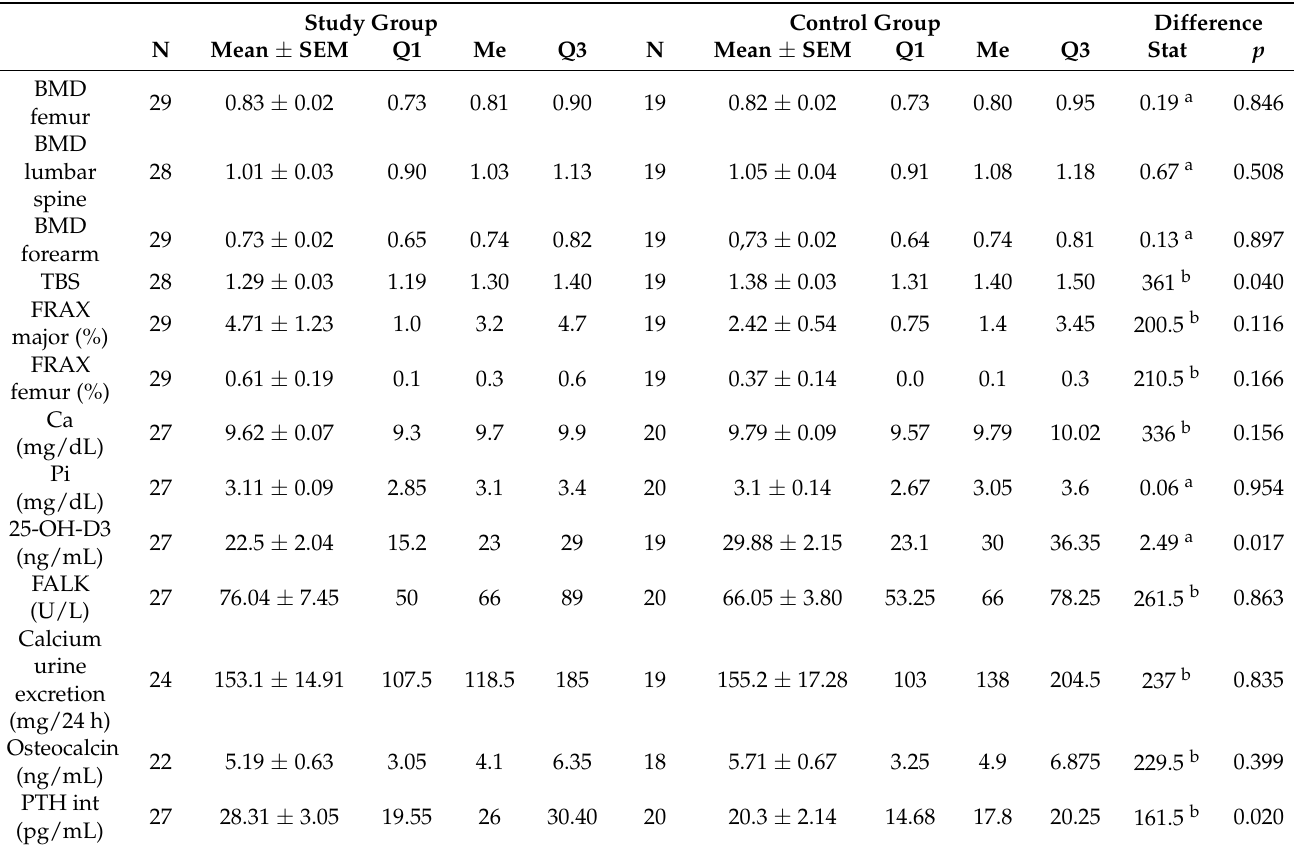
Table 2. Densitometric and laboratory parameters of the calcium and phosphate metabolism in the study and control